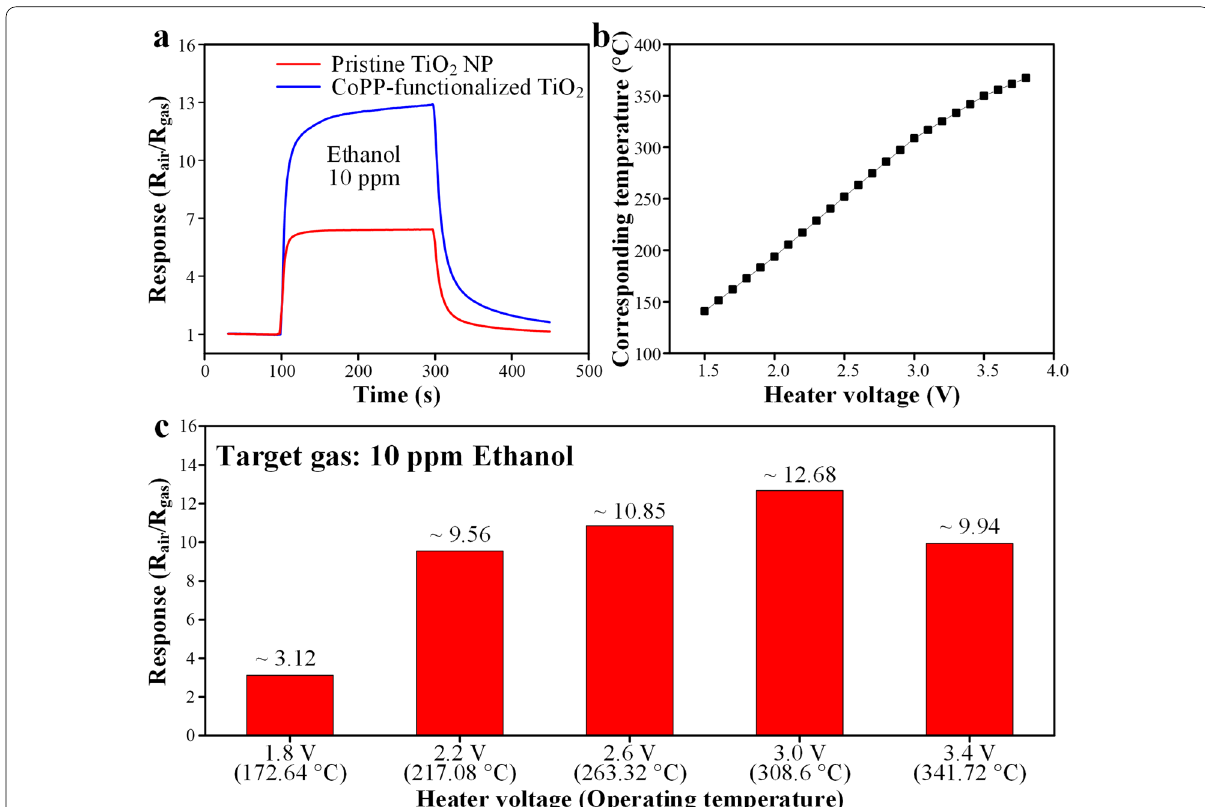
Fig. 2 a Sensor response of pristine and CoPP-functionalized TiO 2 nanoparticles to 10 ppm ethanol. b Relationship between the input voltage of the micro-heater and corresponding temperature. c Sensor response to 10 ppm ethanol at various operating